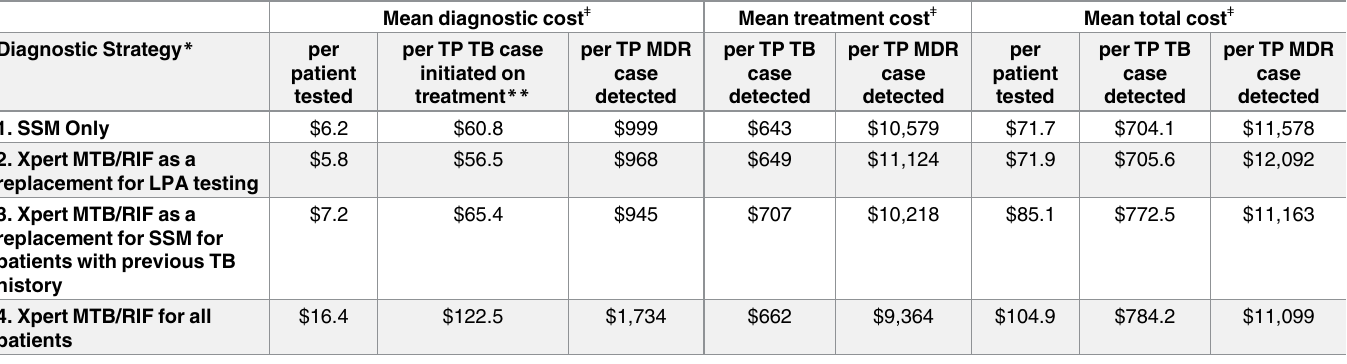
Table 6. Mean costs per patient for 4 diagnostic